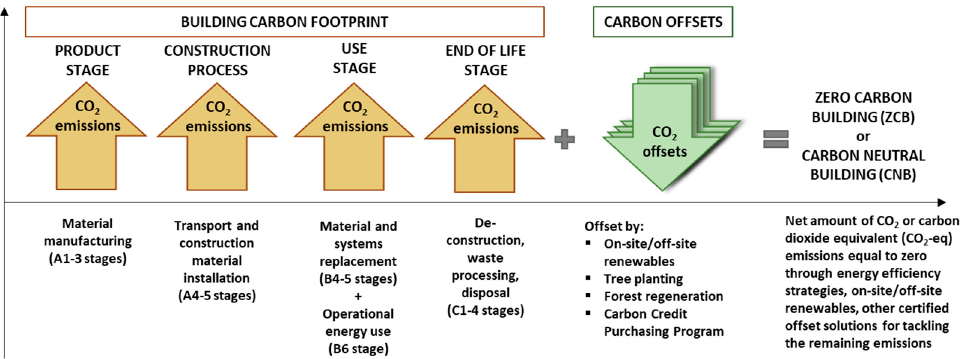
Figure 1. The overall approach to carbon neutrality considered in the study.